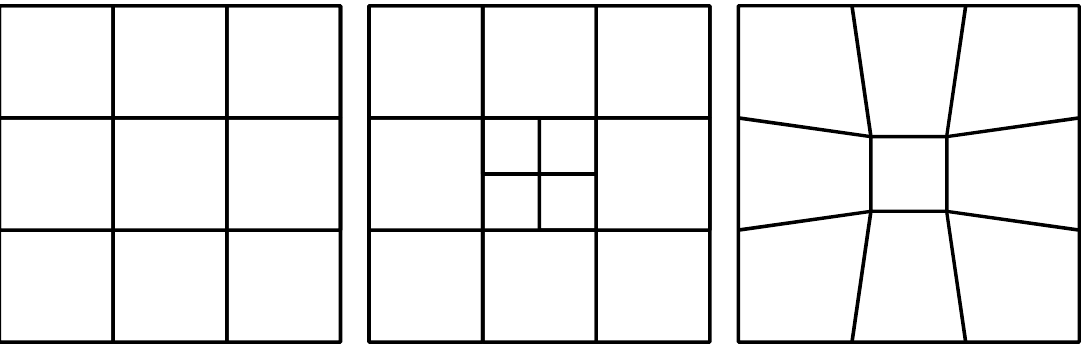
Figure 1. Uniform grid (left) and examples of h-refinement (center) and r-refinement